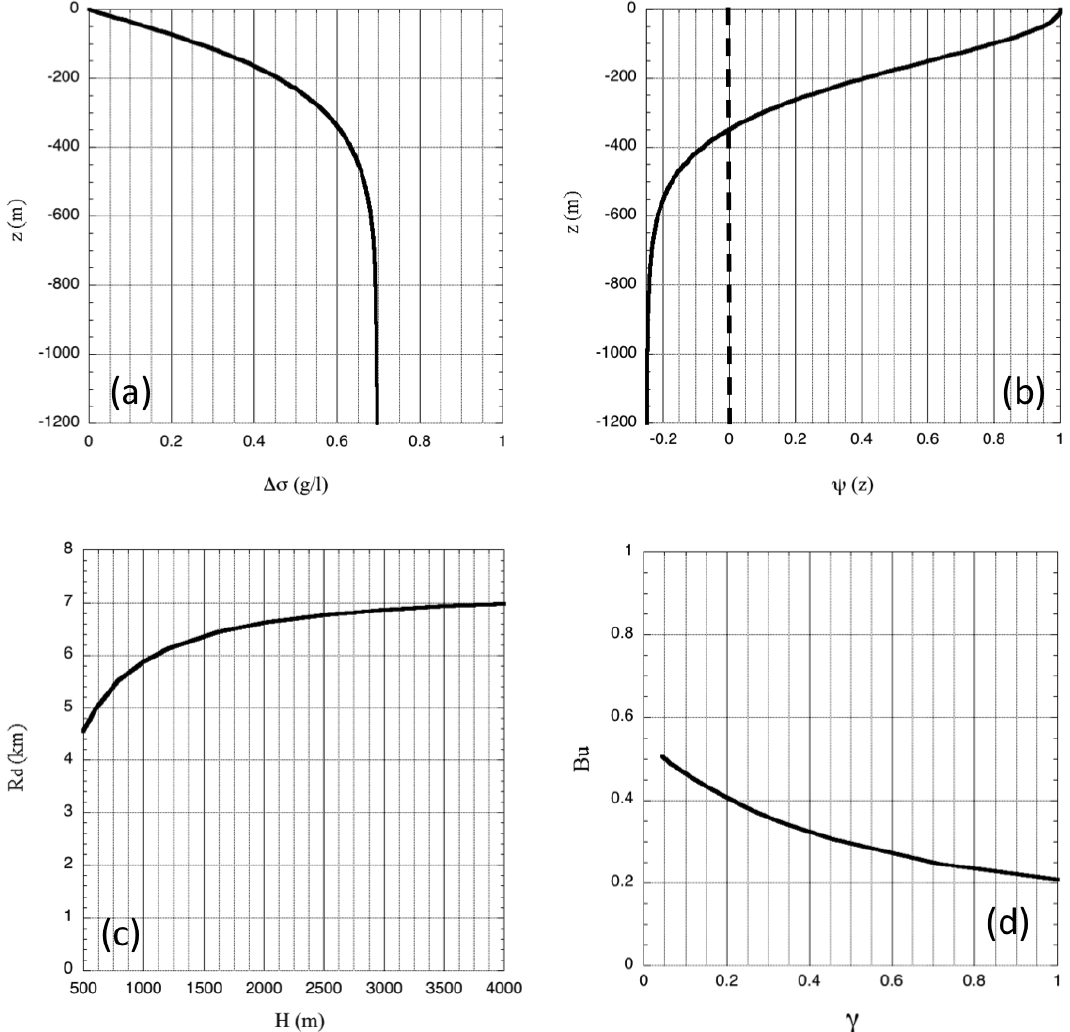
Figure A1. Vertical profile of the potential density anomaly (cid:49)σ(z) (a) and the vertical structure of the first baroclinic eigenmode (b) computed in the centre of the coastal current y = D for a water depth H = 1200m. The evolution of the first baroclinic deformation radius R d is plotted in panel (c) as a function of the water depth H . Panel (d) shows the evolution of the corresponding Burger number Bu = (R d /L) 2 as a function of γ = H jet /(H − H jet )